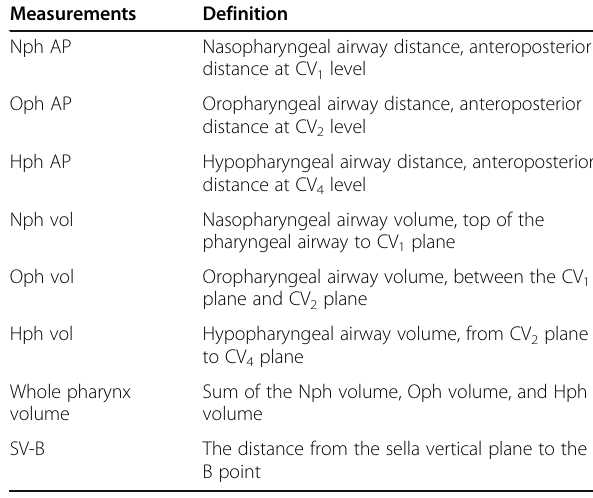
Table 3 Pharyngeal airway